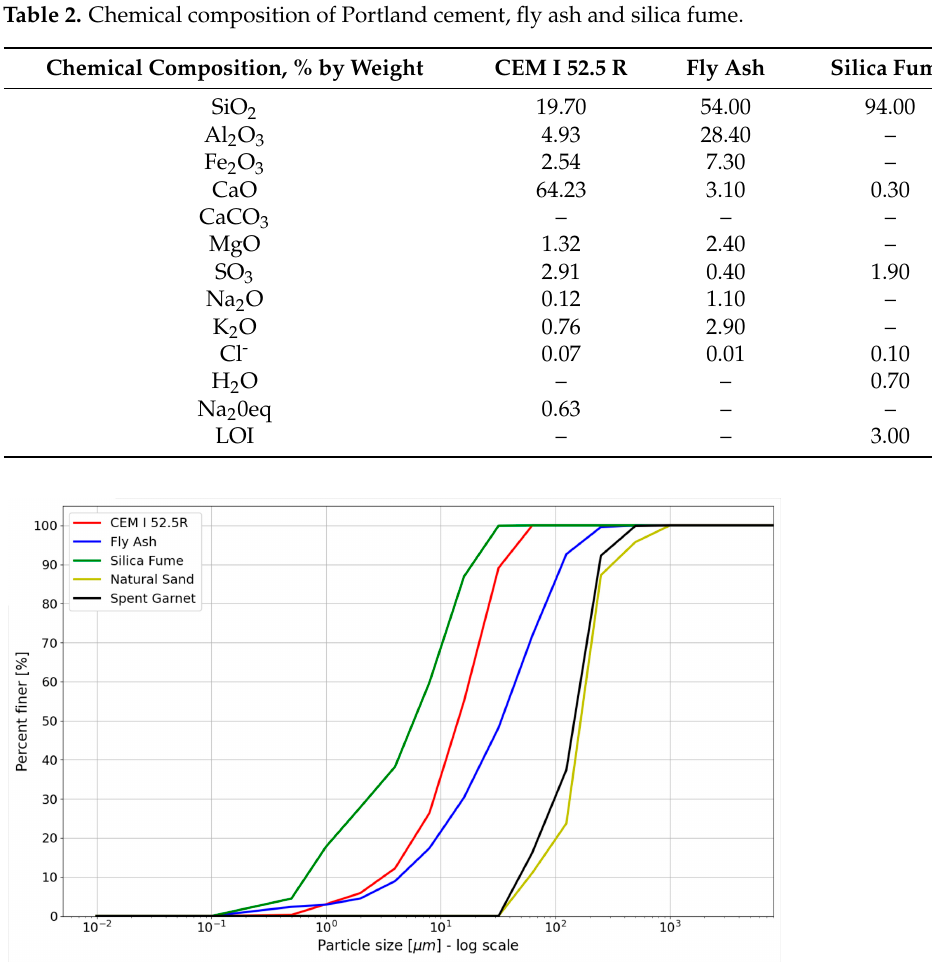
Table 2. Chemical composition of Portland cement, fly ash and silica fume.